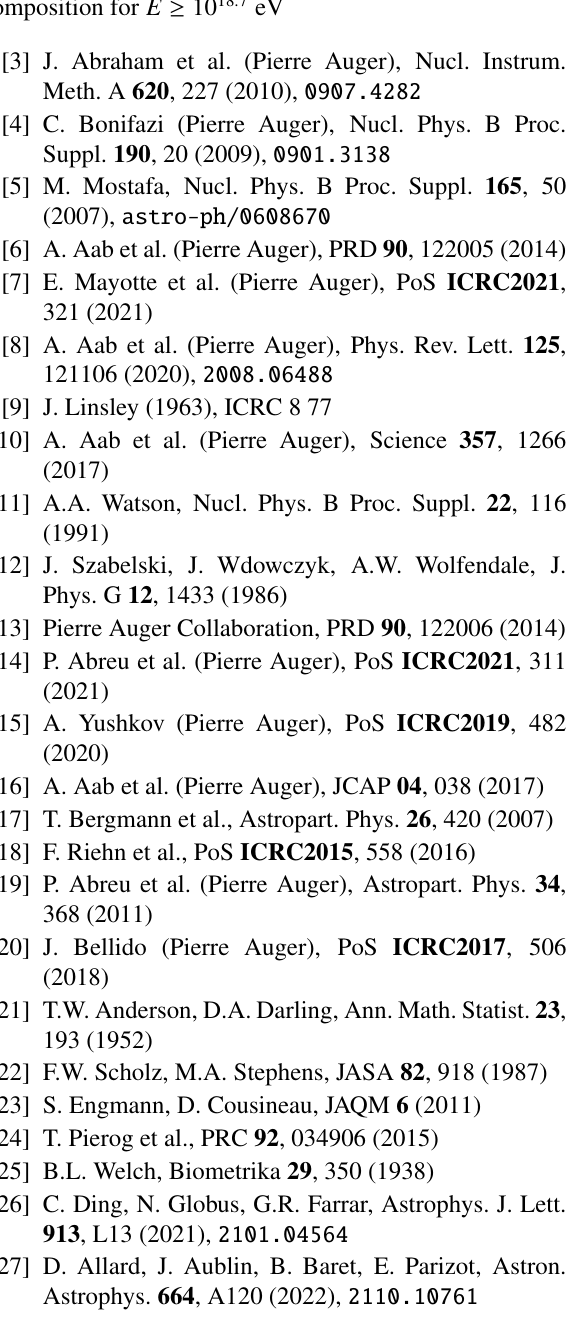
Figure 13: Sky map of comic ray composition for E